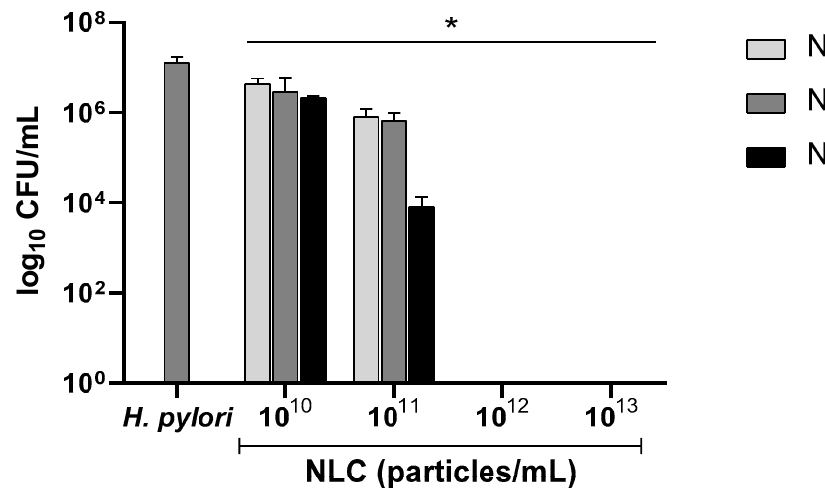
Figure 5. Antibacterial performance of increasing concentrations of NLC60 with different sizes against H. pylori J99. NLC60 S (147 ± 10 nm), NLC60 M (263 ± 8 nm) and NLC60 L (443 ± 11 nm). Assays were performed over 24 h in MHB + 10% FBS medium. Data are expressed as means ± standard deviation. Statistical analysis was performed against the control (bacteria without NLC) using Tukey’s multiple comparisons test. * All samples were statistically significantly different from control ( p < 0.0001).